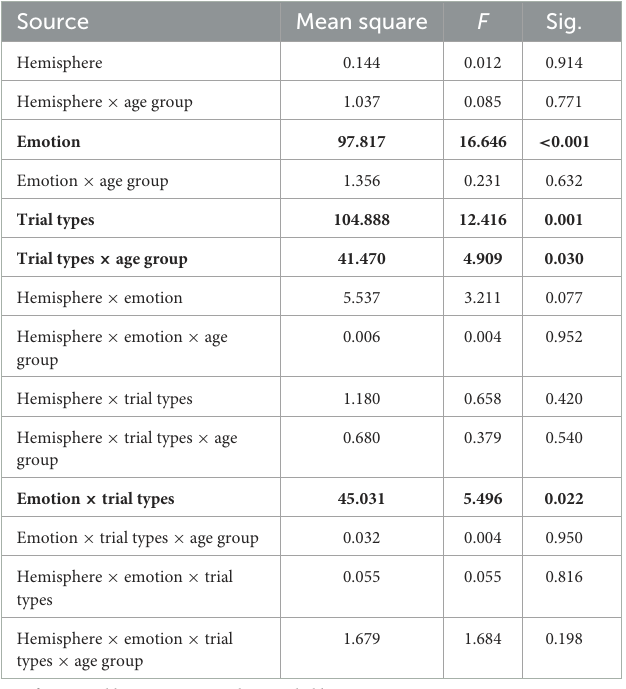
TABLE 2 Repeated-measures ANOVA on the amygdala activation.